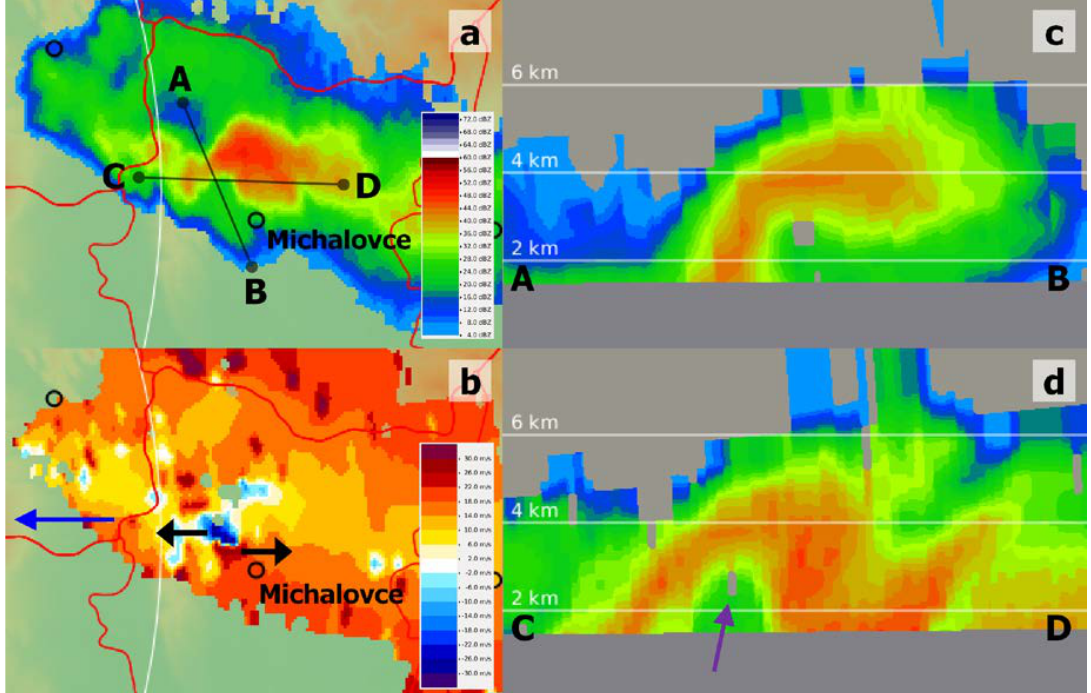
Figure 6. Radar supercell features near Michalovce on 3 October 2018 13:50 UTC, observed from Kojšovská hoľa station, ( a ) CAPPI 2 km (dBZ). ( b ) Radial velocity at 1.5° elevation (m . s –1 ); blue arrow points towards the radar location, black arrows indicate mesocyclone. ( c , d ) Vertical cross-sections (dBZ), purple arrow points to bounded weak echo region (BWER). Cross-section locations indicated by AB and CD segments.